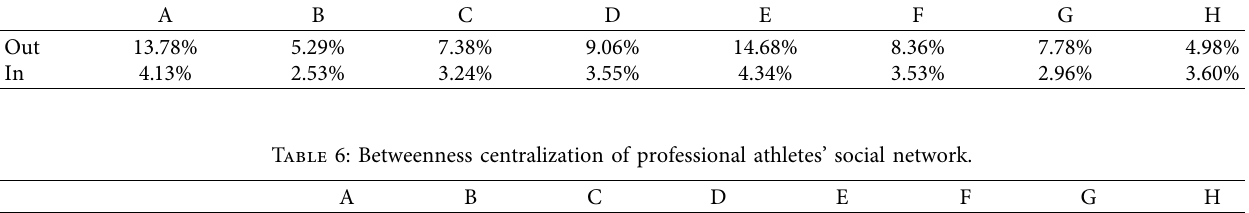
Table 5: Degree centralization of professional athletes’ social network.